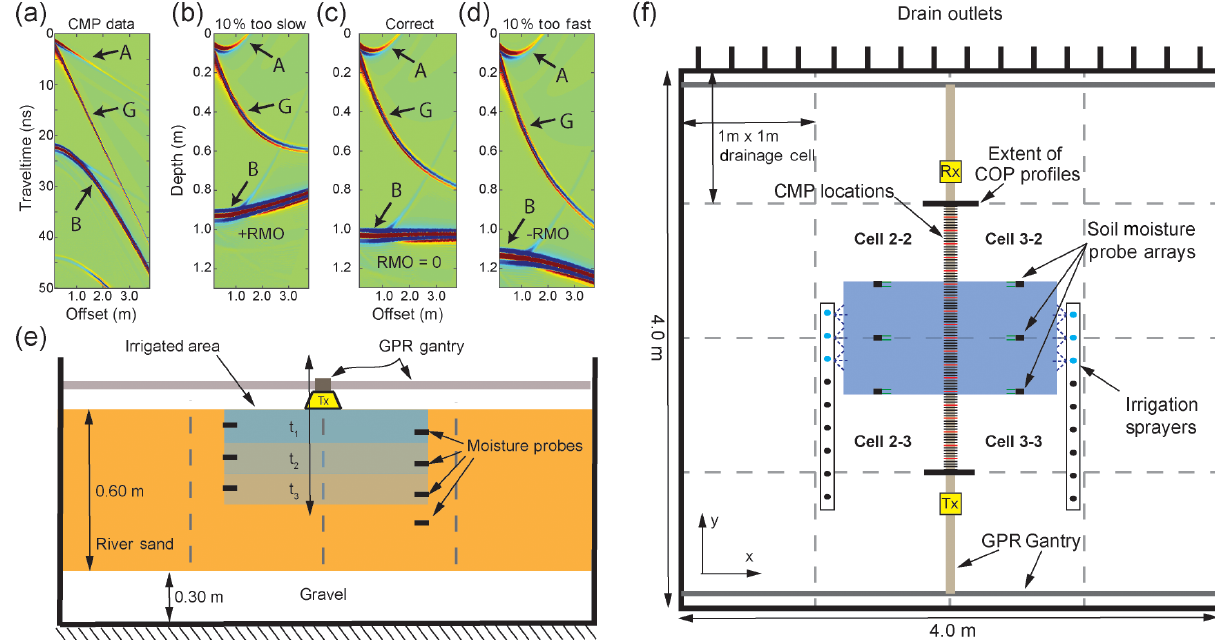
Figure 1. (a) Example CMP data showing the airwave ( A ), groundwave ( G ), and reflection from a layer ( B ). Data in (a) are migrated to form (b) a migrated gather with velocity 10% too slow; (c) a migrated gather with correct velocity; and (d) a migrated gather with velocity 10% too fast. Panel (e) shows a cross section of the experiment at y = 2 . 0m where t 1 , t 2 , and t 3 are arbitrary times during the infiltration. Panel (f) shows the plan view of the experiment. Note that the bottom of the sand layer is flat where GPR data collection occurs, i.e., on a boundary between drain cells, and pitched elsewhere toward cell